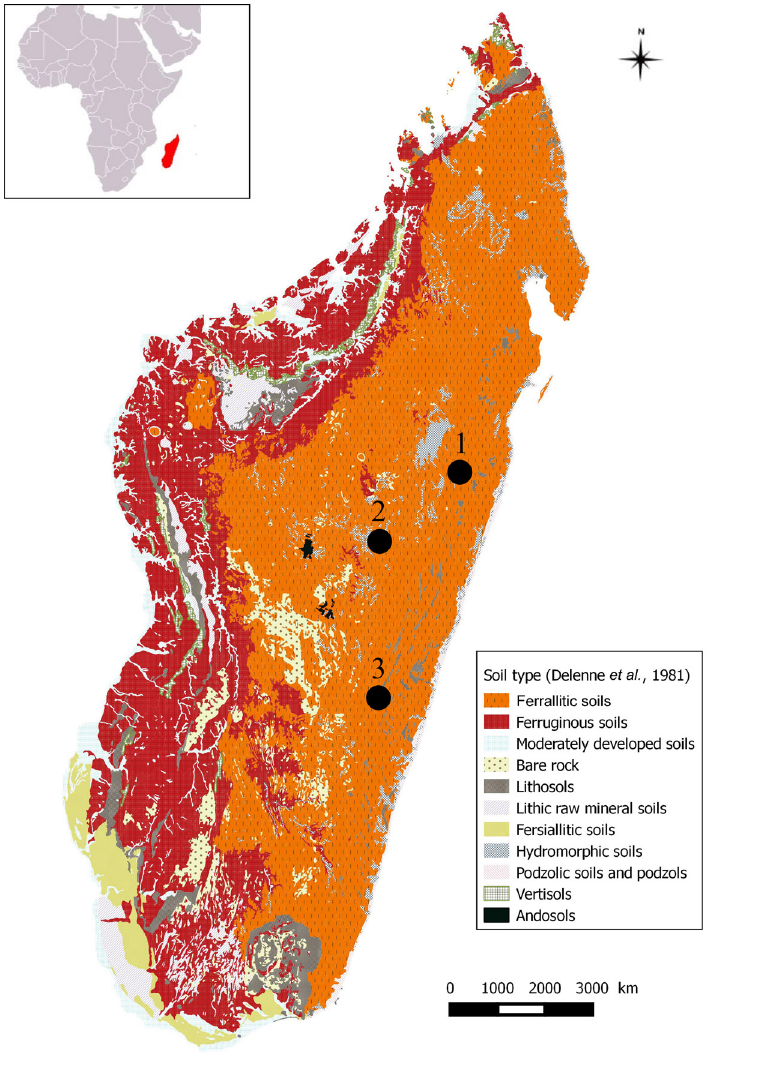
Fig. 1. Main soil types of Madagascar, with indication of the sampling localities. 1 = Moramanga District, Andasibe, Voimma Community Park; 2 = Antsirabe District, Sambaina; 3 = Ambalavao District, Mt Ankisira National